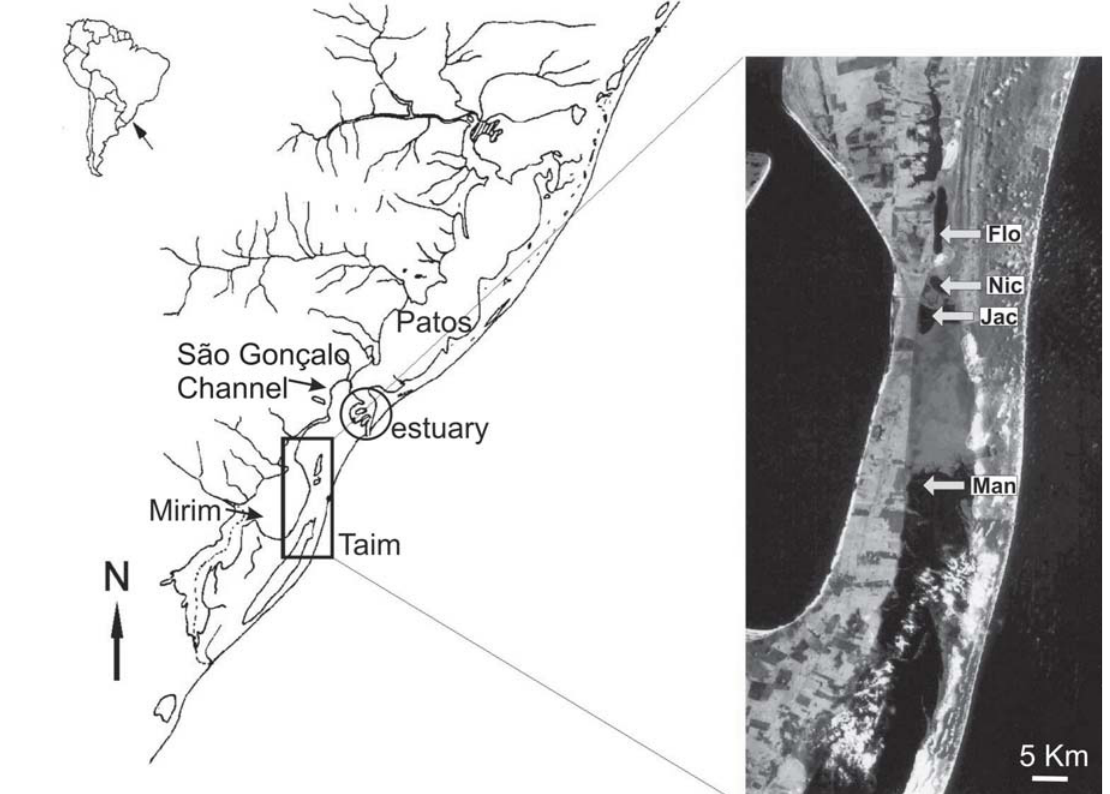
Fig. 1. Patos-Mirim lagoon complex in southern Brazil (left) and Taim Ecological Reserve area (right) with location of sample stations across studied lakes: Flores (Flo), Nicola (Nic), Jacaré (Jac) and Mangueira Norte